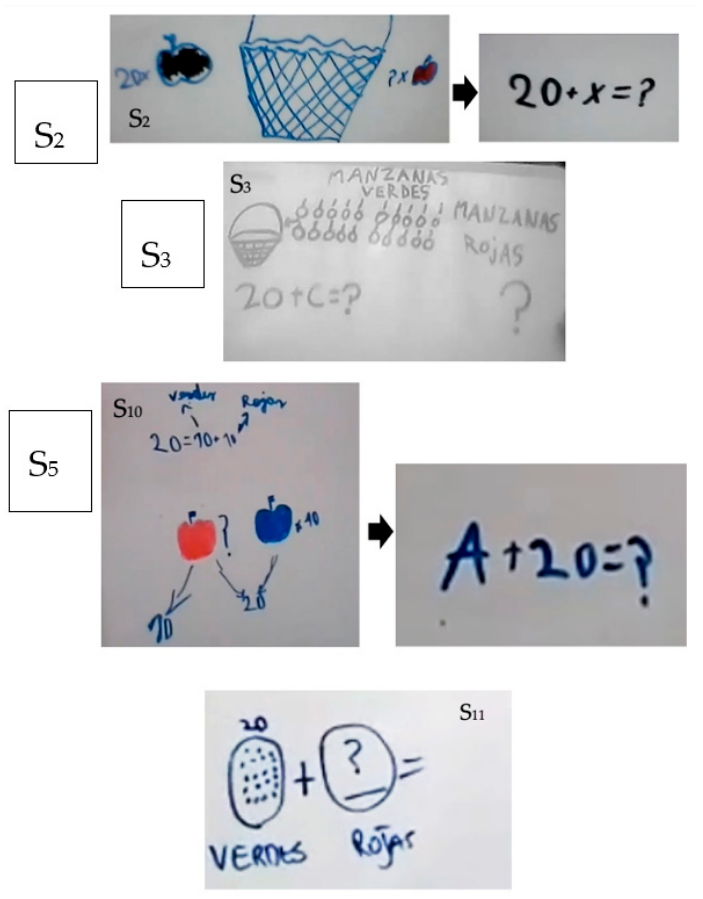
Figure 6. Translation of the verbal statement of pupils S 2 , S 3 , S 5 and S 11 .